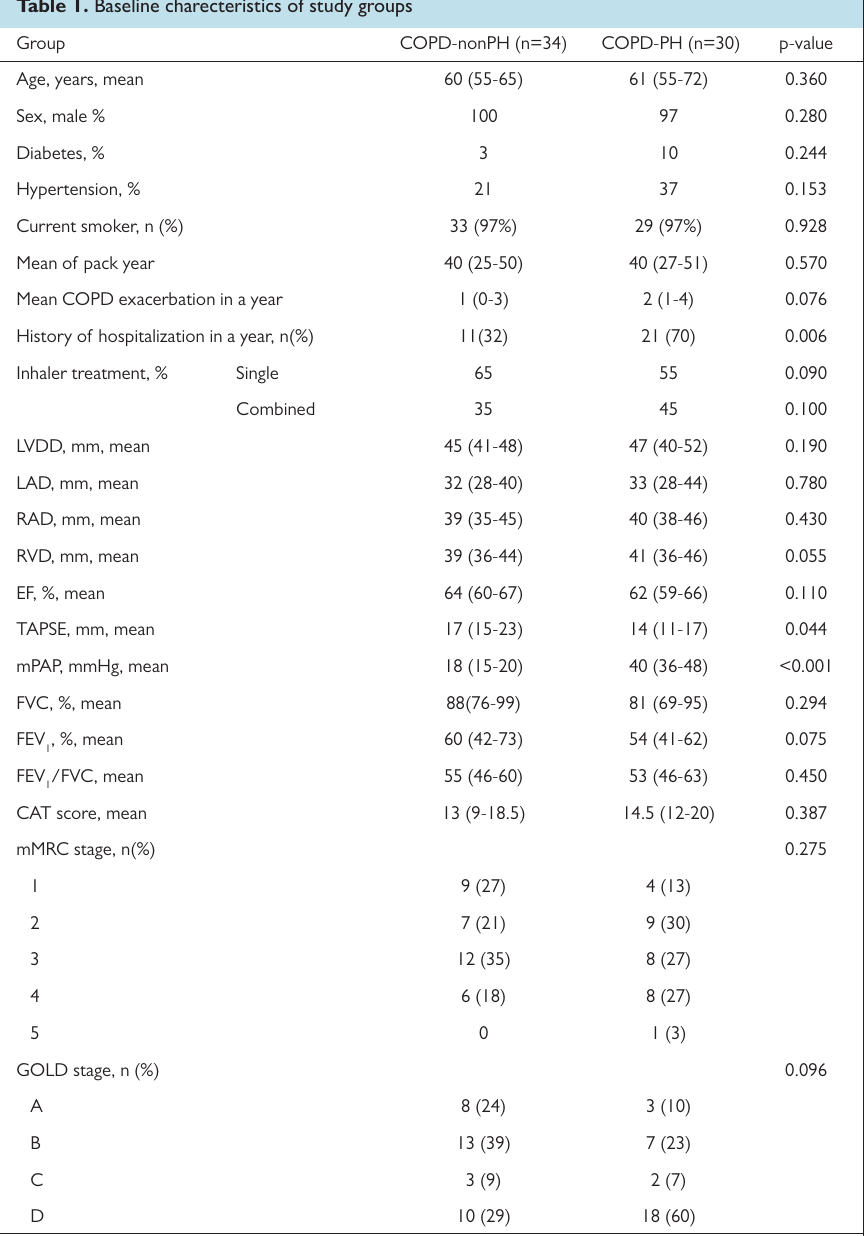
Table 1. Baseline charecteristics of study groups